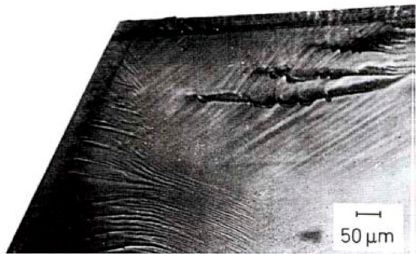
Figure 1. NdAl 3 (BO 3 ) 4 epitaxial layers of 50 µ m thickness on Gd 0.59 La 0.41 Al 3 (BO 3 ) 4 substrate [30]. Reprinted from the Journal of Crystal Growth, 47, Lutz F., Leiss M., Müller J., Epitaxy of NdAl 3 (BO 3 ) 4 for thin film miniature lasers, 130–132, Copyright (1979), with permission from Elsevier.